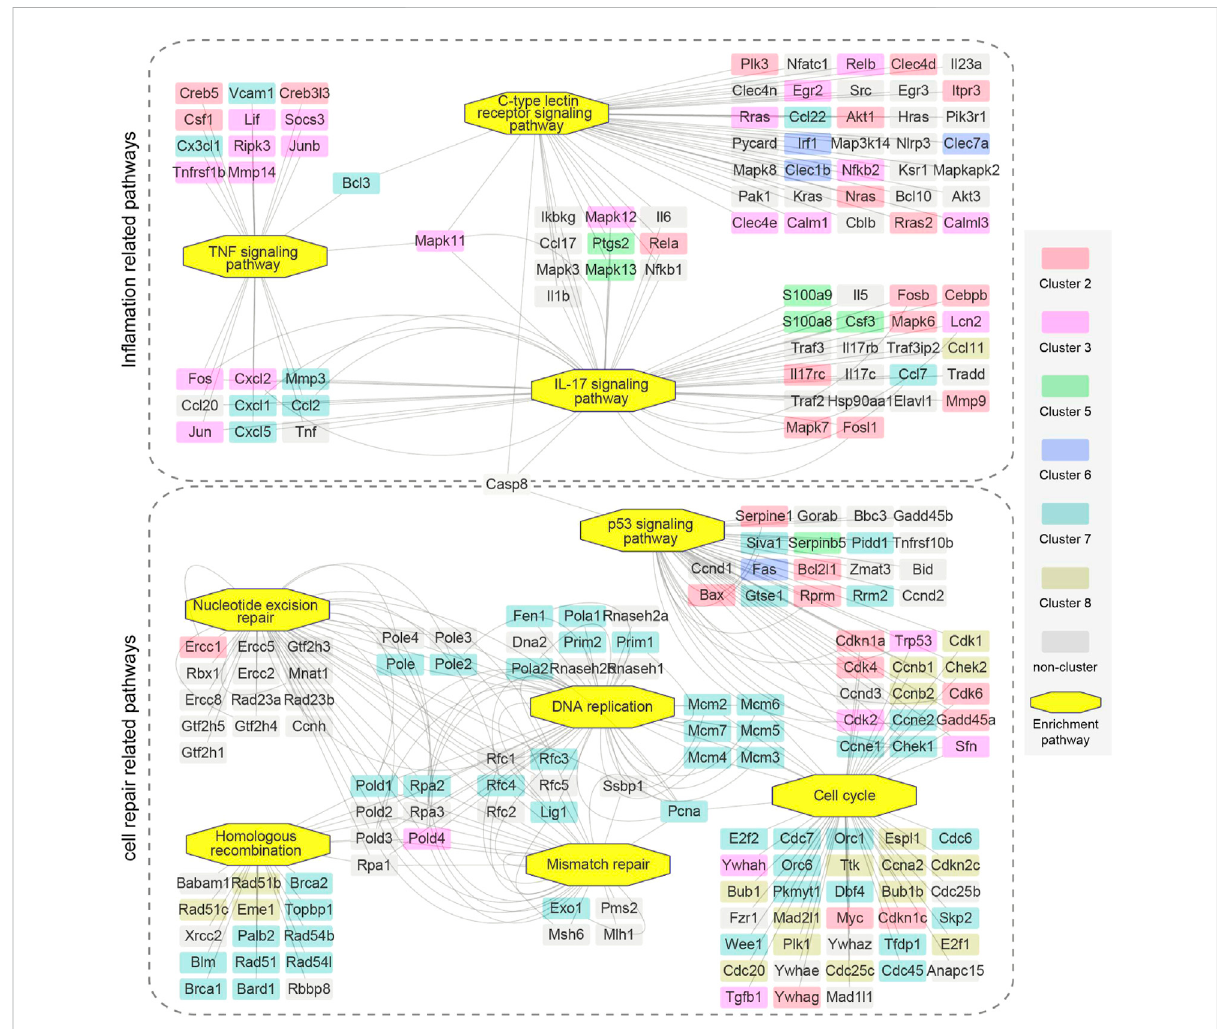
FIGURE 7 TherelationshipofupregulatedenrichmentpathwaysinGSEAanalysisofgenesin16 min – 0 mingroupand28 min – 26 mingroup.Twodotted boxes represent functional modules of in fl amation related pathways and cell repair related pathways. The rectangles represent genes and the octagons represent GSEA enrichment pathways. Different colors represent genes enriched in different clusters. Genes are connected based on the pathways they belong to. GSEA, gene set enrichment